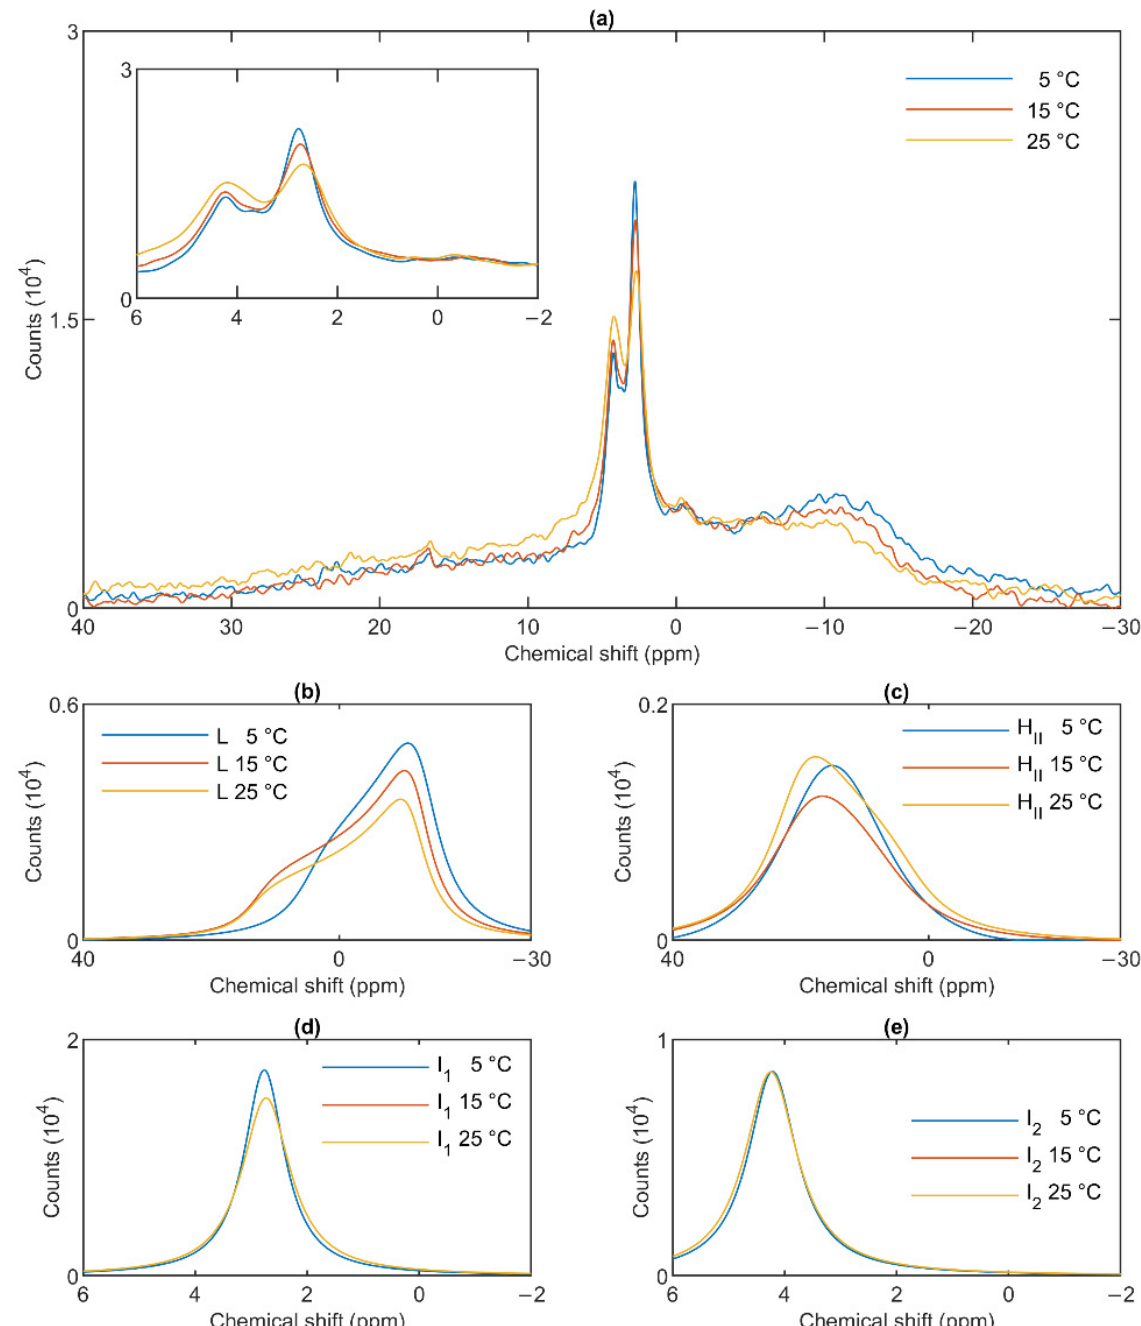
Figure 5. 31 P-NMR spectra of stroma thylakoid membranes at different temperatures ( a ) and their component spectra showing variations in L, the lamellar phase ( b ), H II , the inverted hexagonal phase ( c ), and the two isotropic phases, I 1 ( d ) and I 2 ( e ). The experiments were performed by gradually increasing the temperature from 5 to 35 ◦ C, with data acquisition times between 1 and 2 h. Two experiments on two independent batches, possessing similar spectra, were averaged. The inset in Panel a shows the isotropic region.